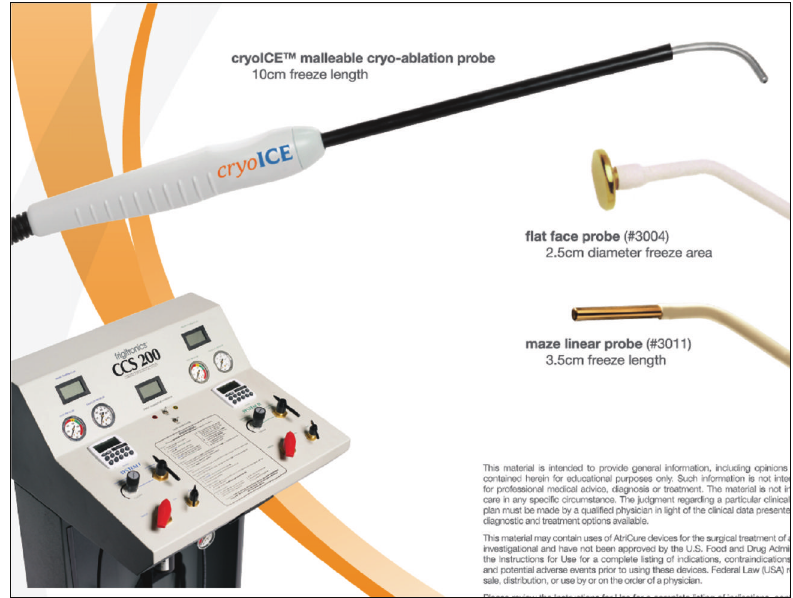
Figure 5: N 2 O-based CryoICE TM Probe (Atricure, Inc., West Chester, OH,